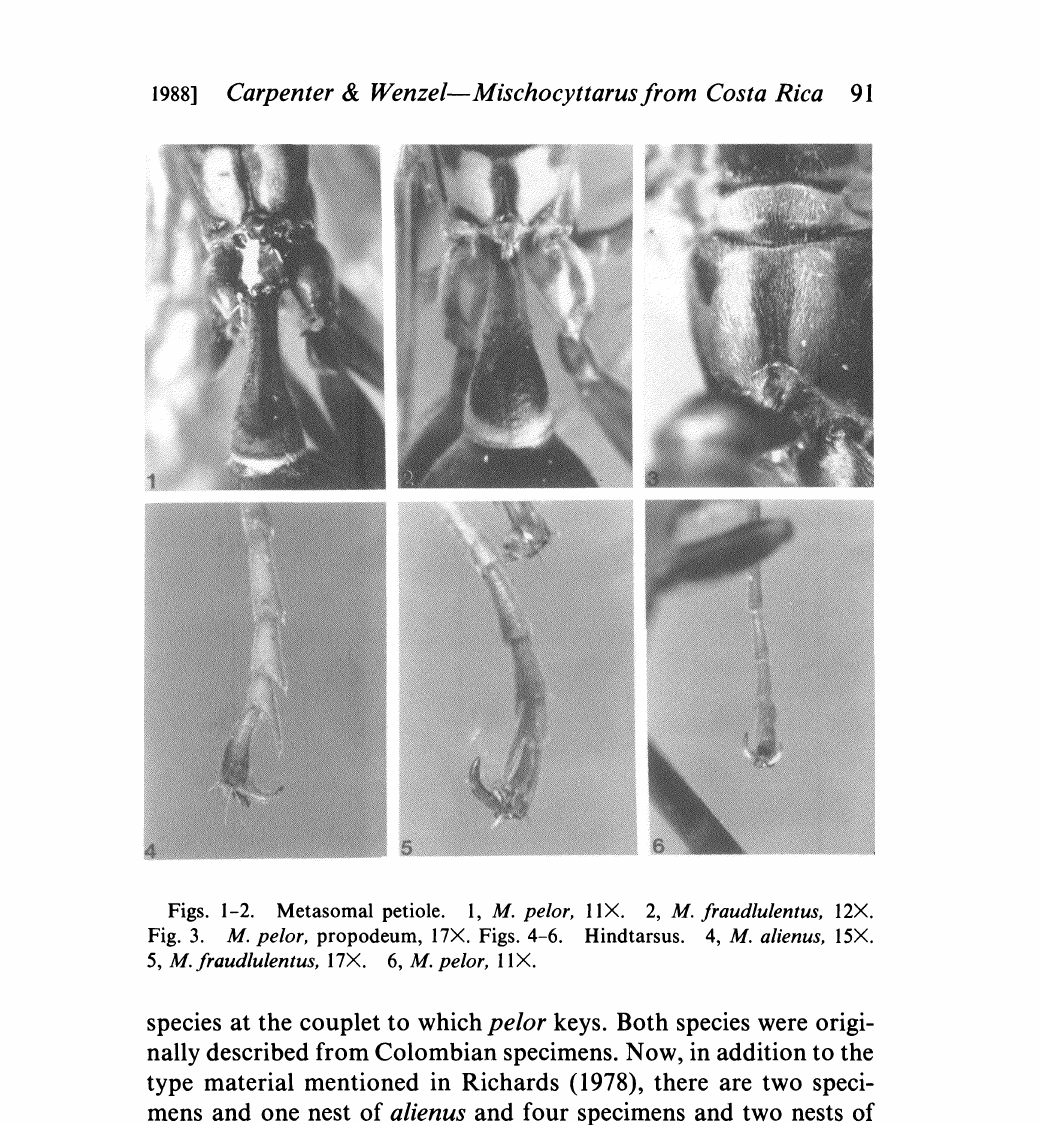
Figs. 1-2. Metasomal petiole. 1, M. pelor, lX. 2, M. fraudlulentus, 12. Fig. 3. M. pelor, propodeum, 17>(. Figs. 4-6. Hindtarsus. 4, M. alienus, 15. 5, M. fraudlulentus, 17X. 6, M. pelor,